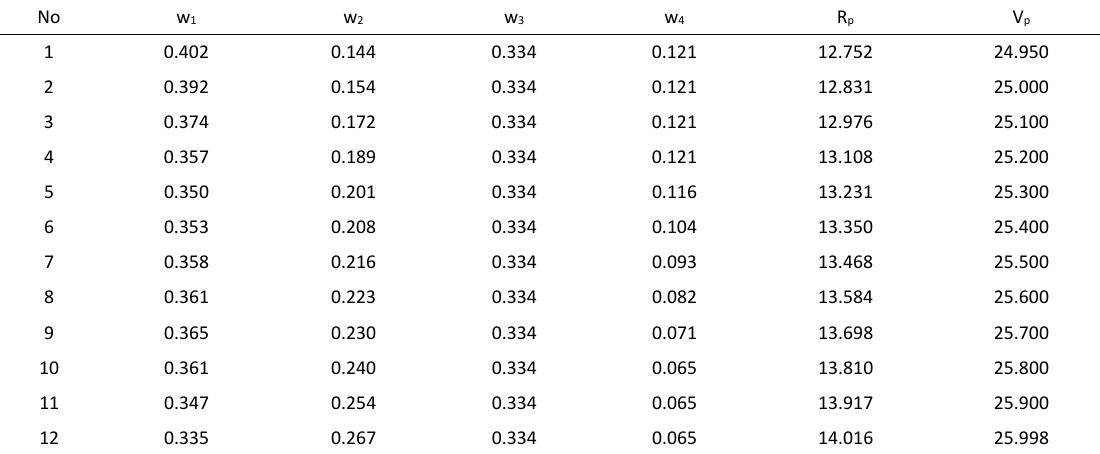
Table 4: The set of optimal portfolios